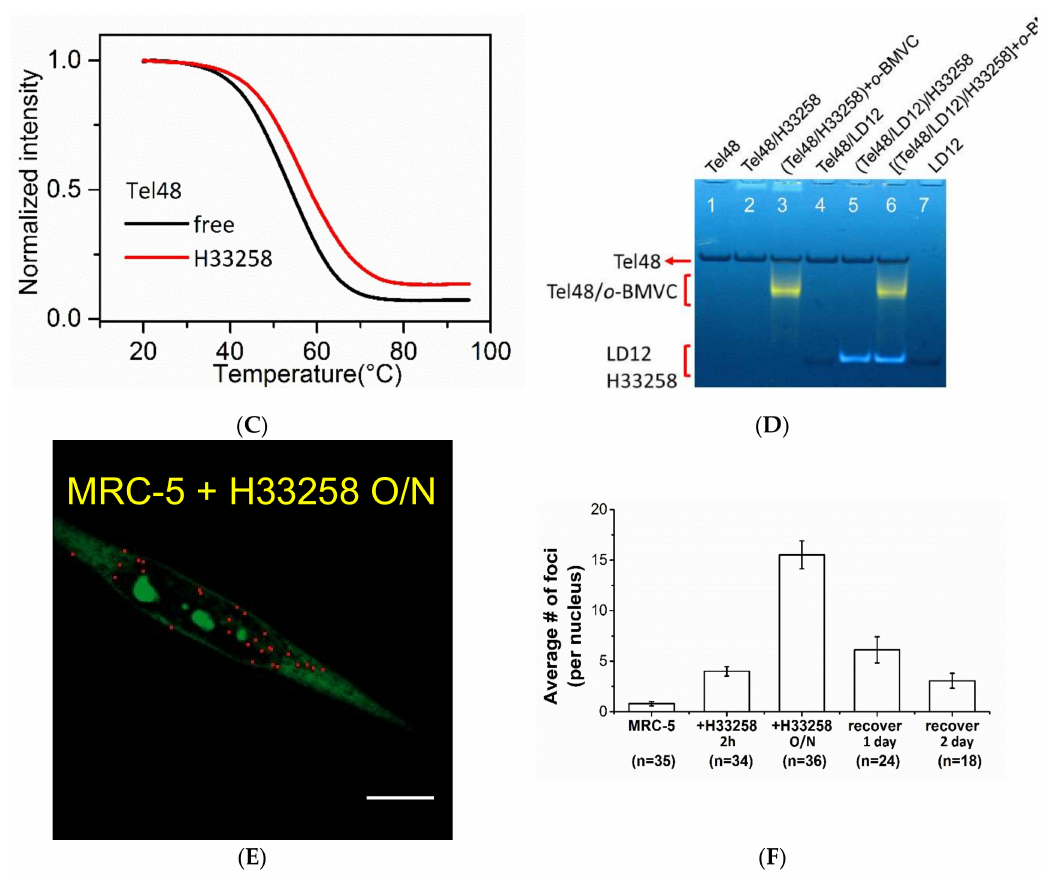
Figure 4. The effect of H33258 on G4 foci in cells. ( A ) The absorption and fluorescence spectra of 15 µ M H33258 and its complexes with 15 µ M Tel48 and 15 µ M LD12. The Tel48 and LD12 sample were prepared in 100 mM K + solution. ( B ) The CD spectra of 4 µ M Tel48 in Tris buffer without and with 8 µ M H33258 and 100 mM K + at 25 ◦ C. ( C ) The CD melting curves of Tel48 in 100 mM K + solution without and with H33258. ( D ) The pre-stained gel assays of Tel48 (lane 1), Tel48/H33258 (lane 2), (Tel48/H33258) + o -BMVC (lane 3), Tel48 + LD12 (lane 4), (Tel48 + LD12)/H33258 (lane 5), [(Tel48 + LD12)/H33258] + o -BMVC (lane 6) and LD12 (lane 7). The concentration of Tel48, LD12 and two ligands prepared in 100 mM K + solution were 20, 40 and 20 µ M, respectively. ( E ) The analyzed binary image of o -BMVC foci in MRC-5 normal cells incubated with 10 µ M of H33258 overnight. The image was recorded after the cells fixed using 70% ethanol for 10 min followed by 5 µ M o -BMVC staining for 10 min at room temperature. Scale bar, 10 µ m. The analyzed binary image was separated into two colors: red (decay time ≥ 2.4 ns) and green (decay time <2.4 ns). ( F ) Quantitative analyses of the average number of o -BMVC foci without H33258 and time-dependent H33258 together with the